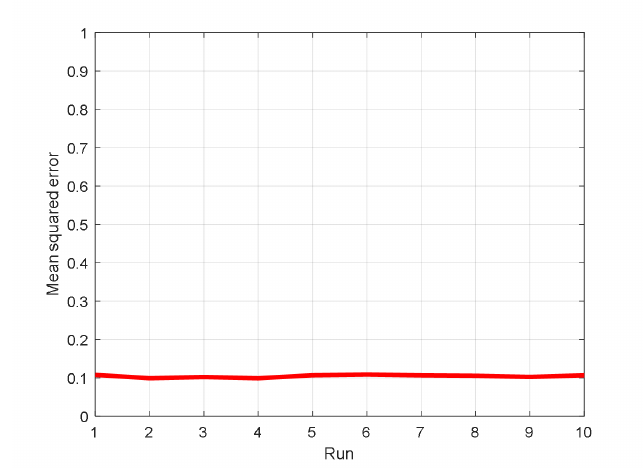
Figure 6. MSE versus number of runs.